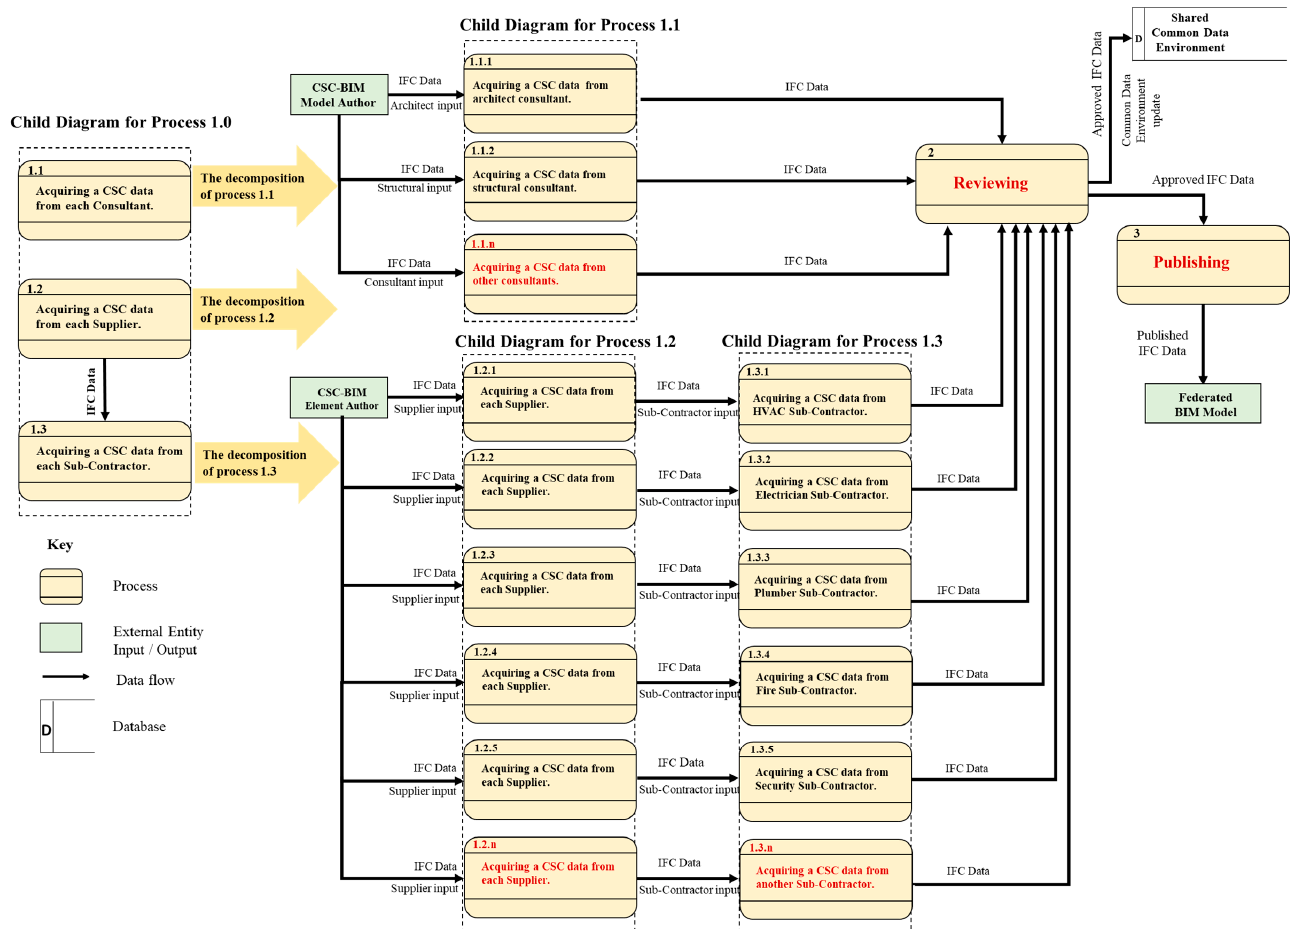
Figure 2. The data flow diagram (DFD) for BIM construction supply chain data delivery.